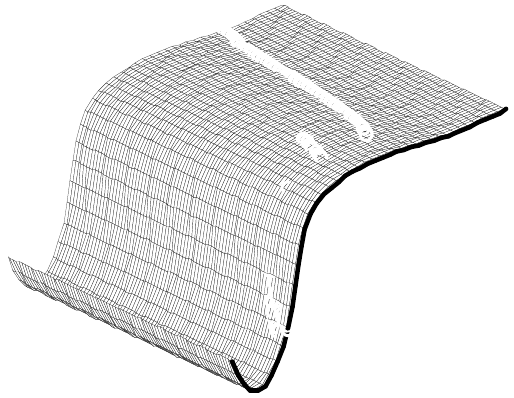
Figure 10. The positions of contact points on the surface of a rail (rail inclination 1:20).